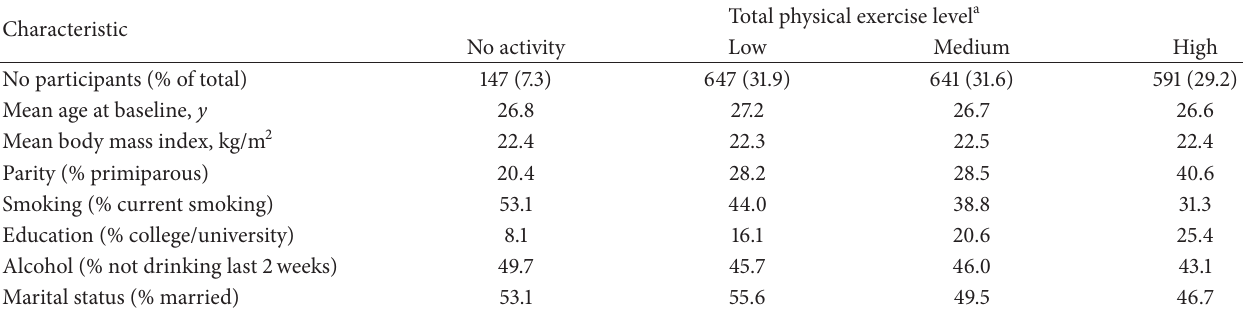
Table 1: Characteristics of the study population ( N = 2,026) according to total leisure time physical